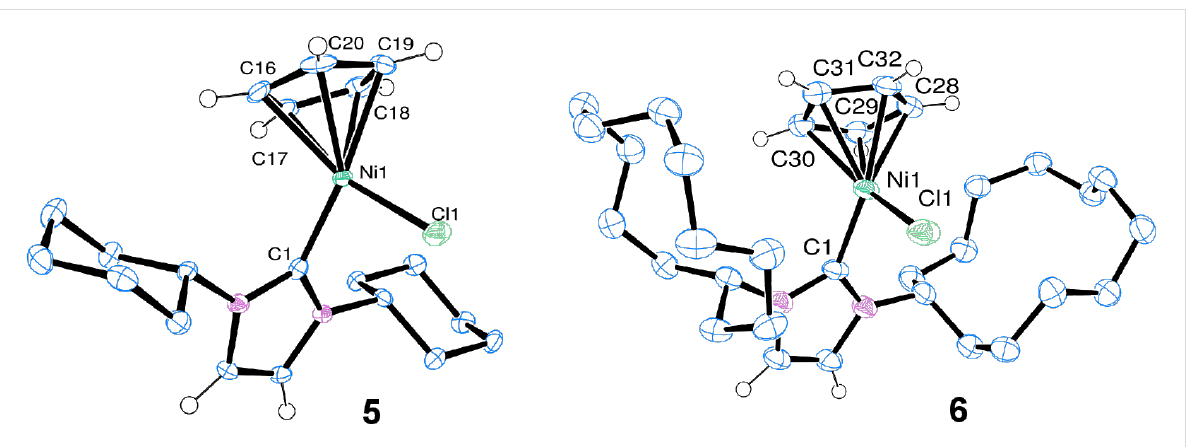
Figure 1: Molecular structures of complexes [NiCl(Cp)(ICy)] ( 3 ) (left) and [NiCl(Cp)(IDD)] ( 4 ) (right) as determined by single crystal X-ray diffraction. Displacement ellipsoids are drawn at 50% probability. Most H atoms are excluded for